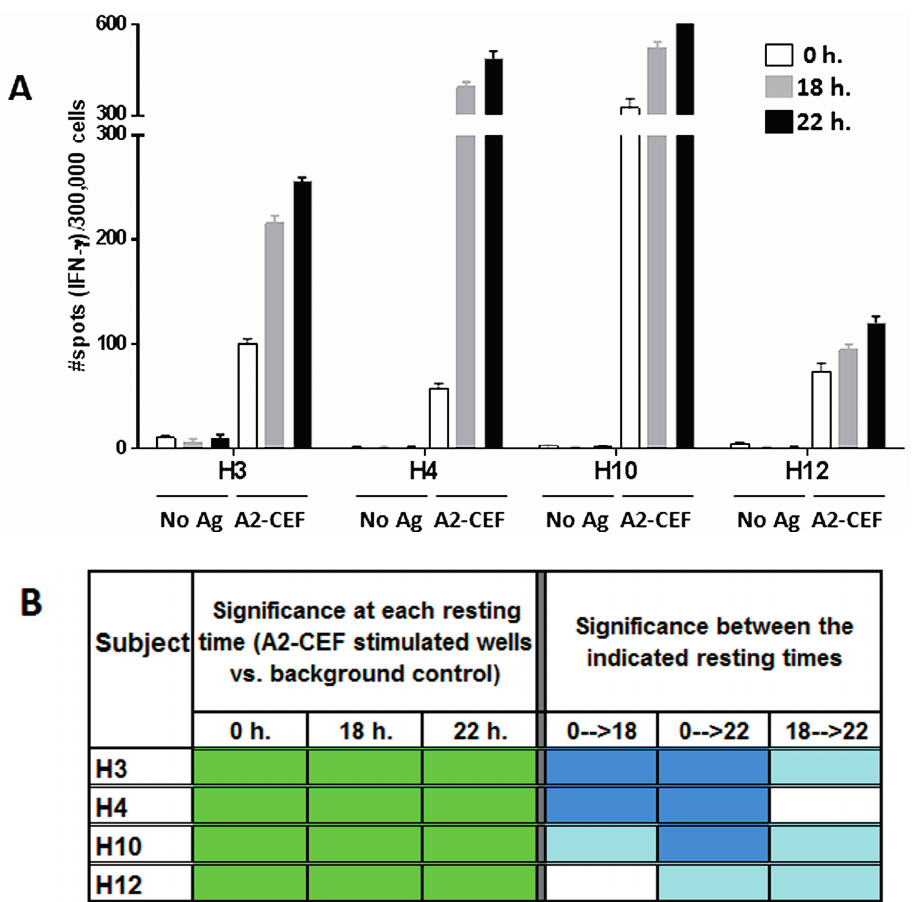
Figure 2. The magnitude of the response to the A2-CEF peptide pool in PBMC samples from normal donors increases with overnight resting. PBMC samples from the indicated donors were thawed and seeded in the presence and absence (no Ag, background control) of the A2-CEF peptide pool after 0 h, 18 h. or 22 h. of resting. ( A ) Results are the average of spots from triplicates wells. ( B ) Statistical significance for the responses to A2-CEF as compare to No Ag at each resting time were determined by modified DFR(2x) (DFR, distribution free resampling) after Westfall–Young max-T correction; p-values <5% are shown in green. The statistical significance of the responses obtained for the three different resting time points was determined by a DFR-like permutation method with Westfall–Young max-T correction; 5% or 10% significances are shown in dark blue or light blue,